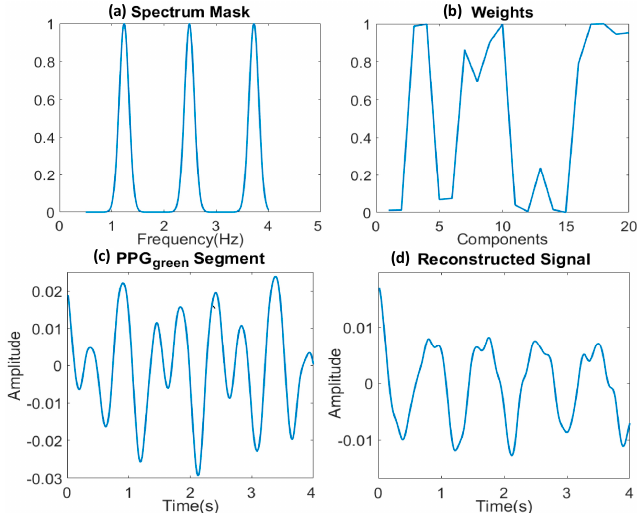
Figure 9. Signal reconstruction step: ( a ) The frequency mask used for signal reconstruction; ( b ) The rescaled weights after SSA decomposition; ( c ) One example of the corrupted PPG signal; ( d ) The corresponding reconstructed PPG signal.